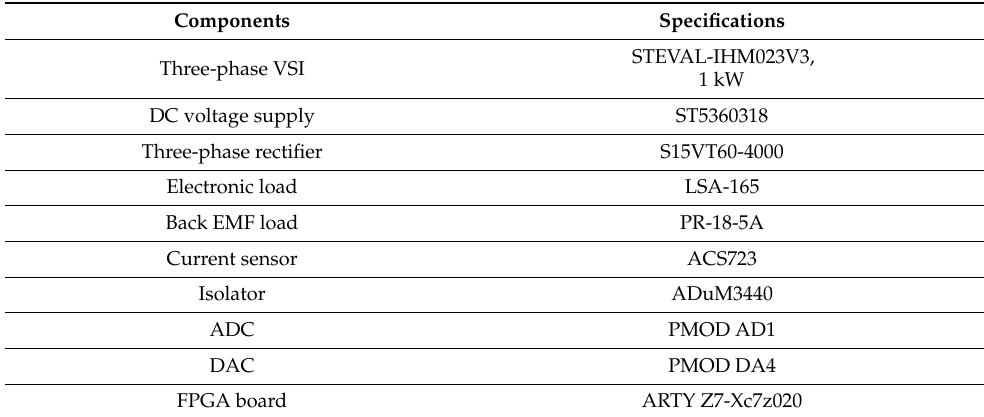
Table 3. Specifications of the